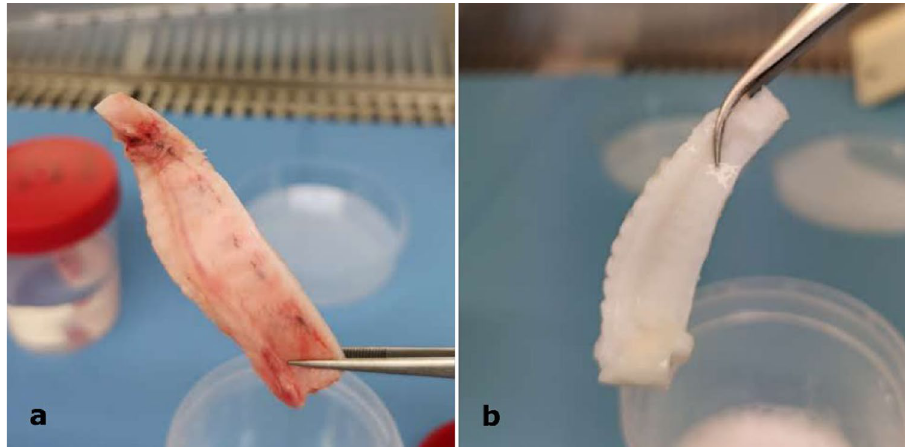
Figure 1. ( a , b ) Representative images of ( a ) non-decellularized and ( b ) decellularized hemi-palates. Each palate was washed in ultrapure water, treated in 4% sodium deoxycholate and then with DNase-I to be finally rinsed in ultrapure water. In order to remove decellularization reagents, samples were then washed with increasing percentages of denatured ethanol and finally rehydrated in ultrapure water. The macroscopic